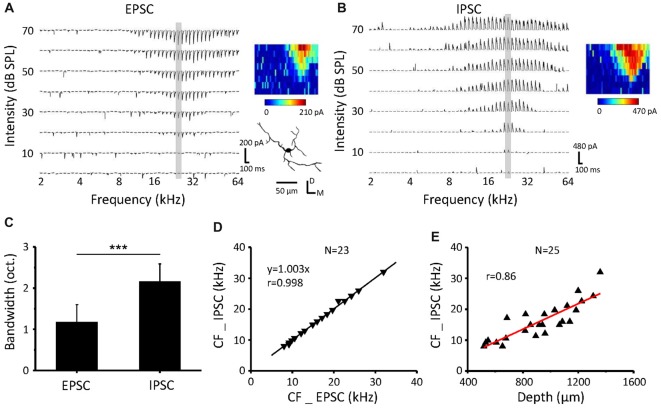
Inhibitory postsynaptic currents (IPSCs) have the same CF but wider BW than excitatory postsynaptic currents (EPSCs) as a response to contralateral stimulation (A,B). An example neuron recorded from the ICC. Tonal receptive fields (TRFs) of synaptic currents evoked by pure tone stimuli at various frequencies and intensities were obtained, with the neuron clamped at −70 mV (A) and 0 mV (B). The color maps on the right indicate the amplitudes of individual synaptic currents. (C) Average bandwidth synaptic TRFs at 60 dB SPL. ***P < 0.001, paired t-test. (D) Comparison of the CF between EPSCs and IPSCs for all the recorded cells. The dotted line is the best-fit linear regression line. (E) The relationship of recording depth and the CF.